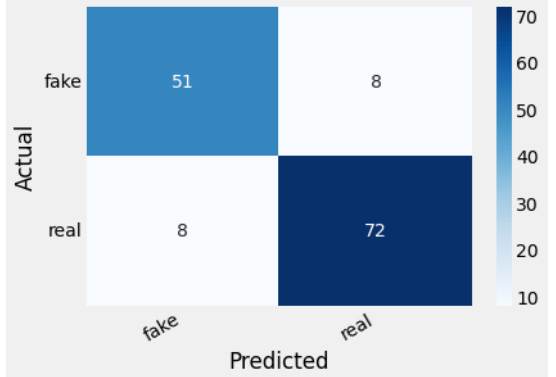
Figure 13. Confusion matrix of BERT base -BiGRU-CNN-ATT in PolitiFact w/o user posting behavior features.